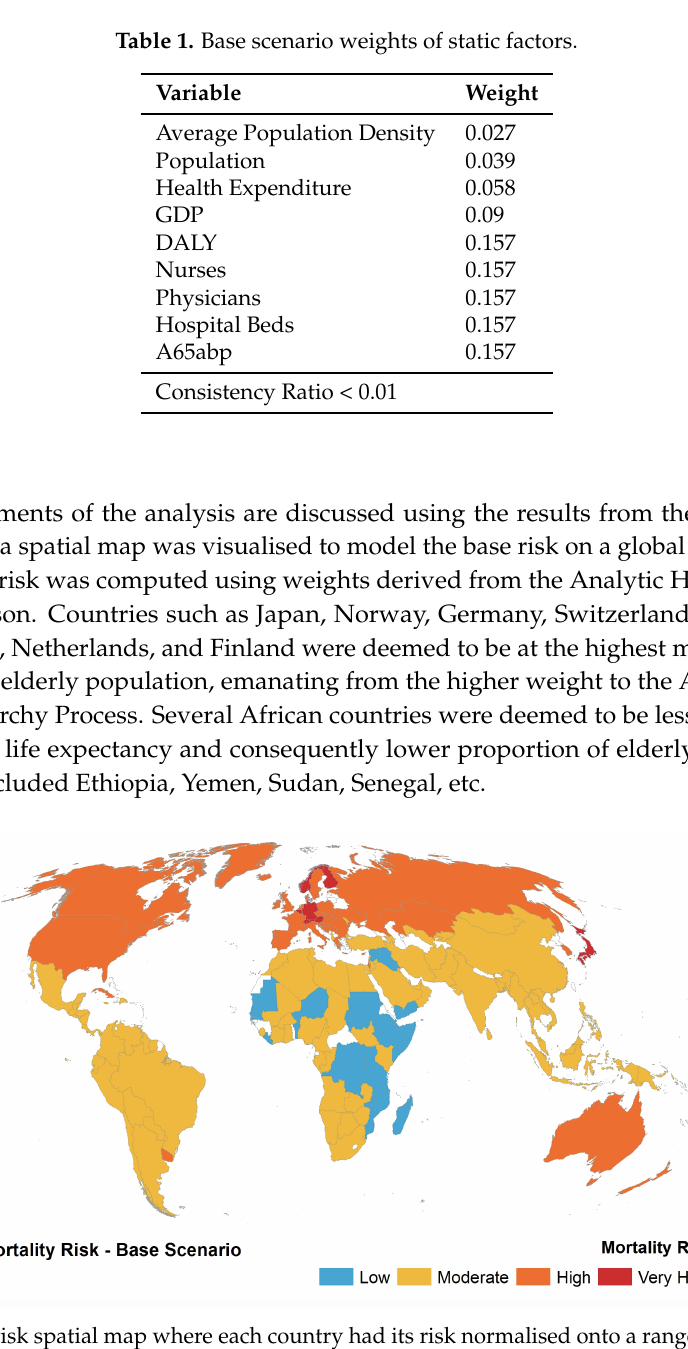
Figure 1. Base risk spatial map where each country had its risk normalised onto a range of 1–4, where 1 indicated as Low risk and 4 as Very High